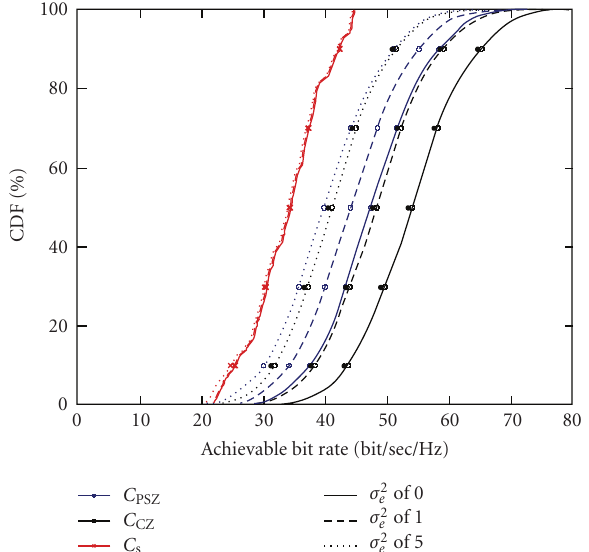
Figure 7: CDF of achievable bit rate using measured 8 × 4 channel matrix with α = 0.